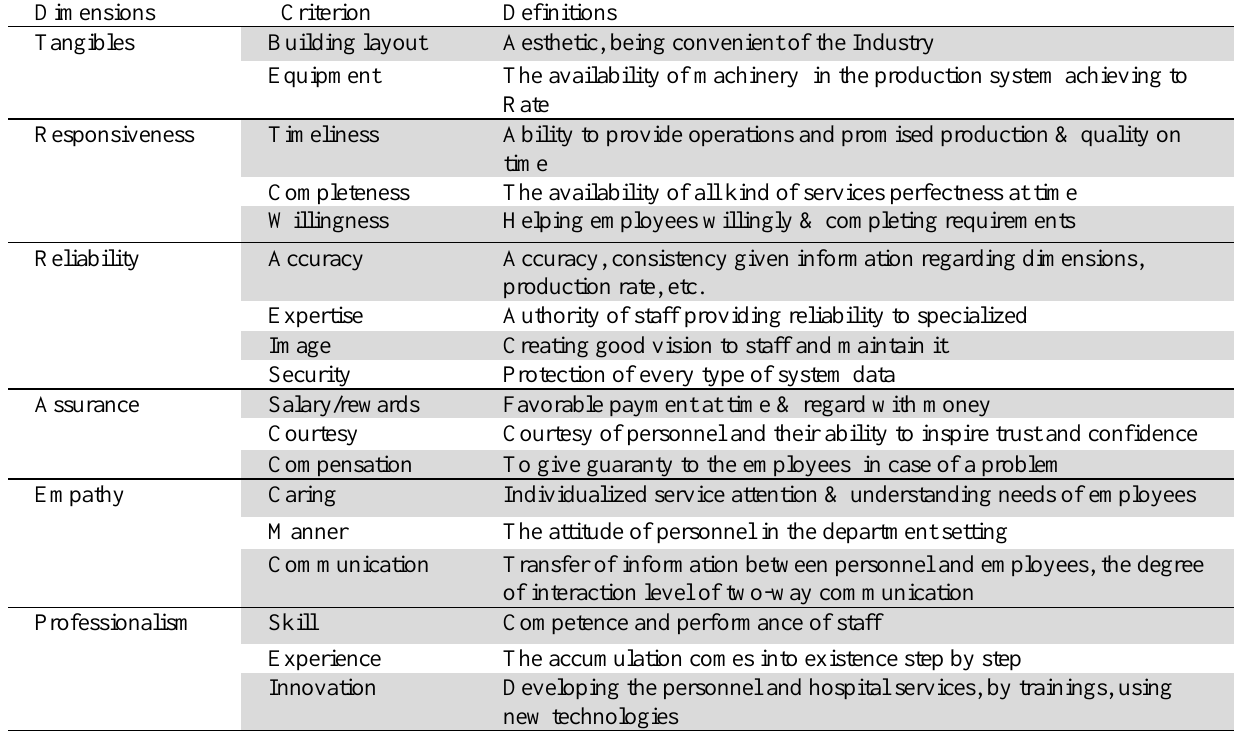
Dimensions for Service